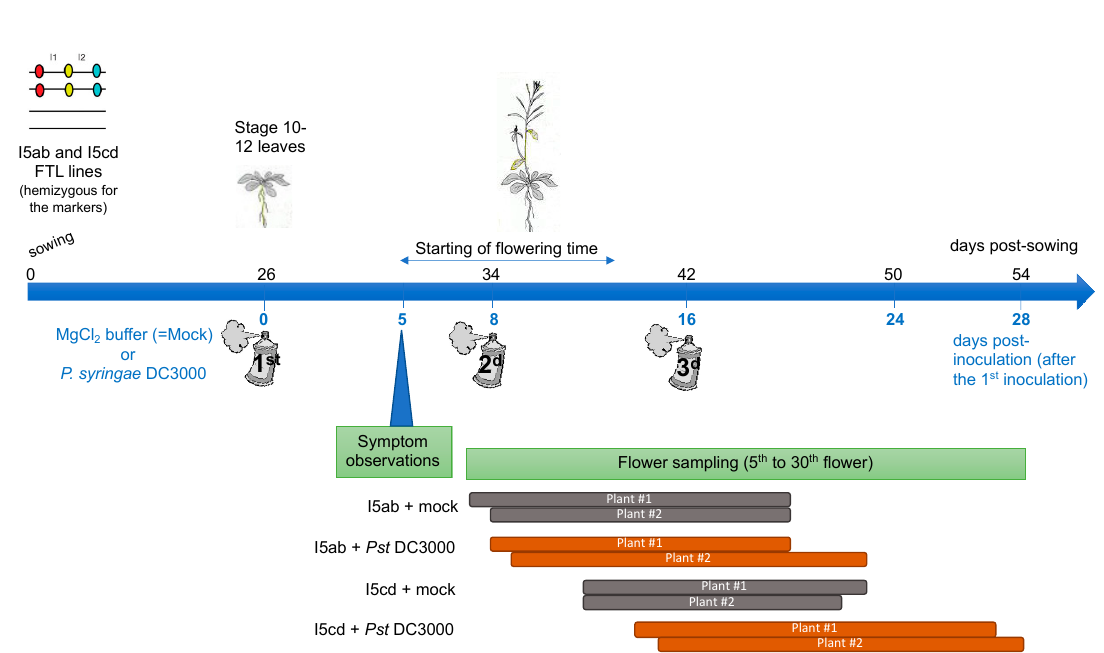
Figure 2. Temporal scheme of the experiment. At the stage 10-12 leaves, rosette leaves of FTL plants were sprayed either with mock-buffer or with P. syringae DC3000 bacteria. Symptoms were observed at 5 dpi. The 5th to the 30th flowers were collected on two plants for each FTL line and for each condition. In order to maintain pathogen pressure during all the experiments, two additional sprays with P. syringae DC3000 or with MgCl 2 buffer were performed 8 (2 d inoculation, t = 8) and 16 days after the first inoculation spray (3 d inoculation, t = 16). For each inoculation, only the rosette leaves were inoculated, since the floral stem and the flowers were protected. The flowers were then collected at di ff erent time after an inoculation: at minimum 0 days after an inoculation, when sampling was done the same day than an inoculation, and at maximum 12 days, for the last collected flowers (at t = 28), since the 3 d inoculation was performed at t =